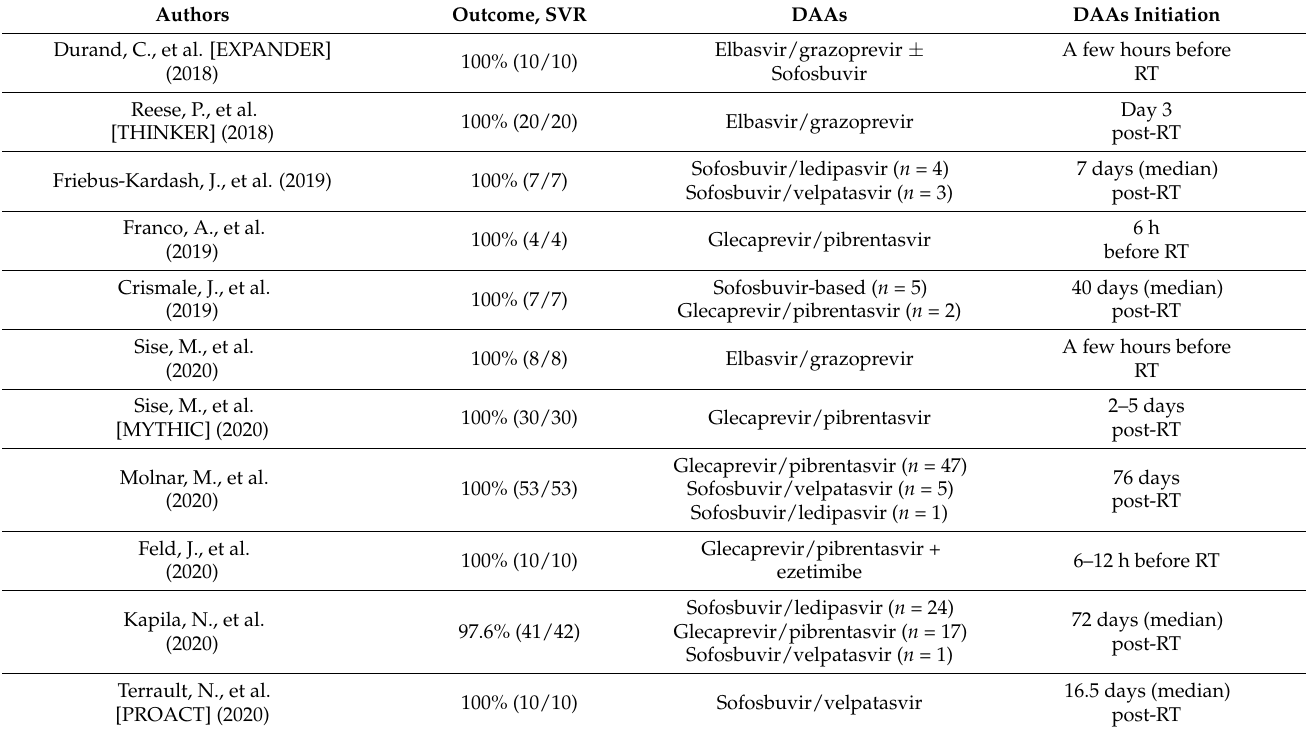
Table 3. Kidney transplant from donors with HCV-viremia (HCV NAT-positive) into HCV-negative kidney recipients and DAAs: clinical